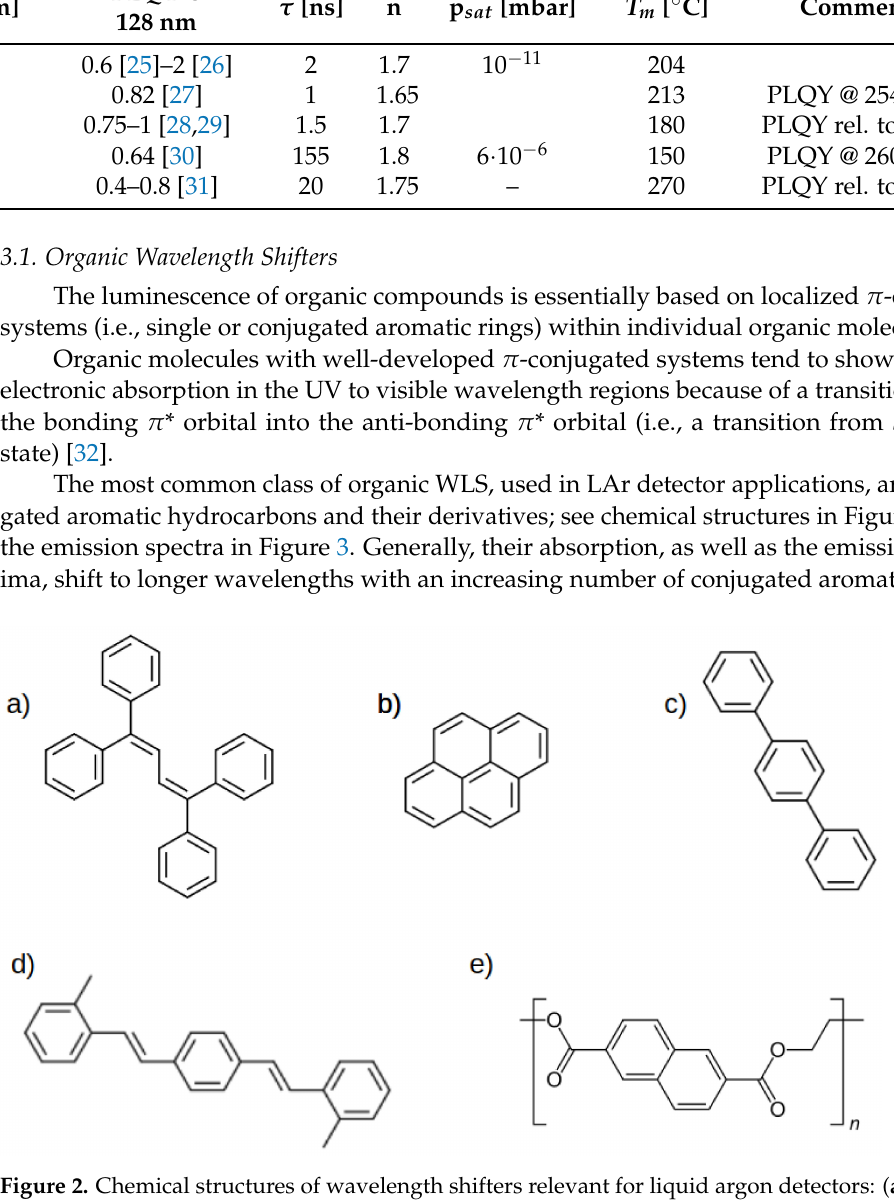
Figure 2. Chemical structures of wavelength shifters relevant for liquid argon detectors: ( a ) 1,1,4,4- tetraphenyl-1,3-butadiene (TPB), ( b ) pyrene, ( c ) p-terphenyl, ( d ) 1,4-Bis(2-methylstyryl)benzene (bis-MSB), ( e ) polyethylene naphthalate